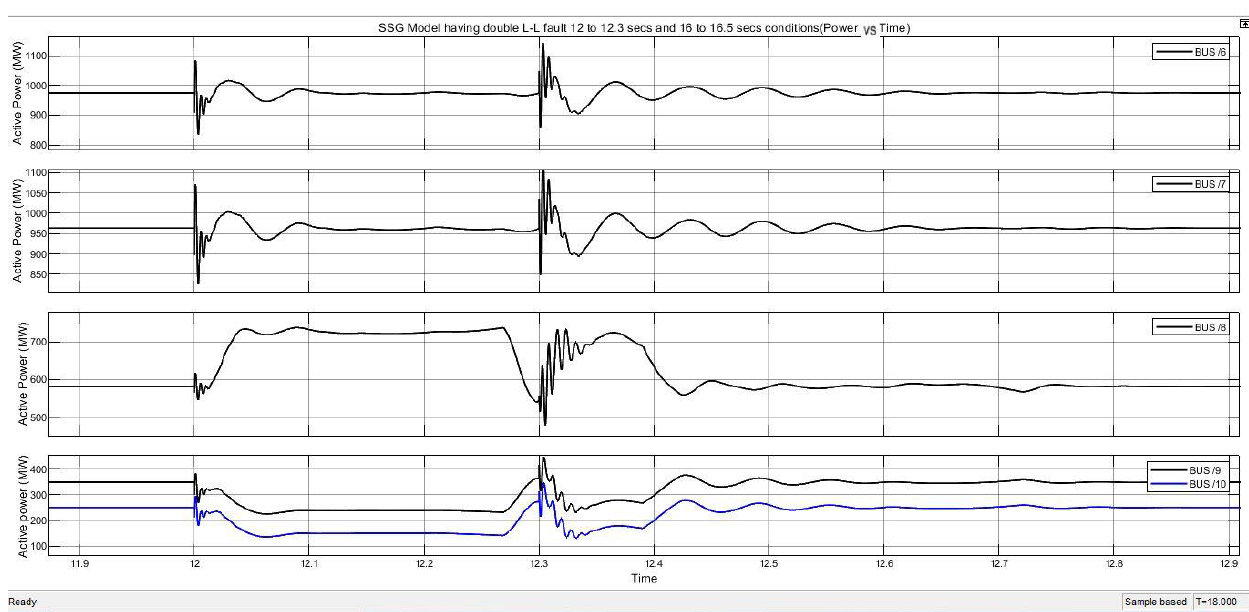
Figure 25. Multiple double line to line (L-L) faults are inserted in the system from 12 to 12.3s (Bus 6 to Bus 10).